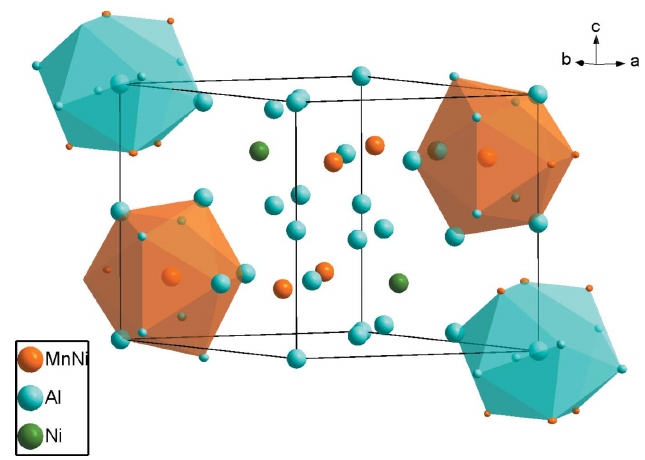
Figure 1 The crystal structure of Al 20 Mn 5.37 Ni 1.31 with two (Mn1/Ni1) sites and two Al1 atoms displayed with their coordination environments as